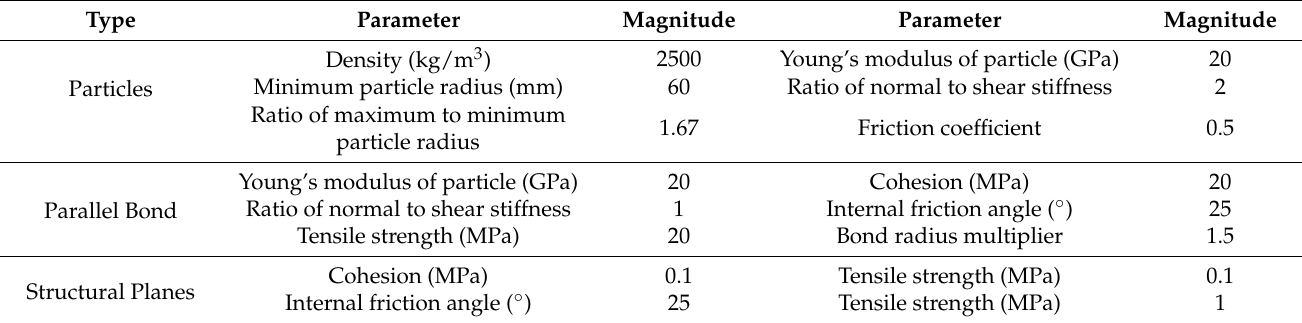
Table 3. Microscopic parameters in